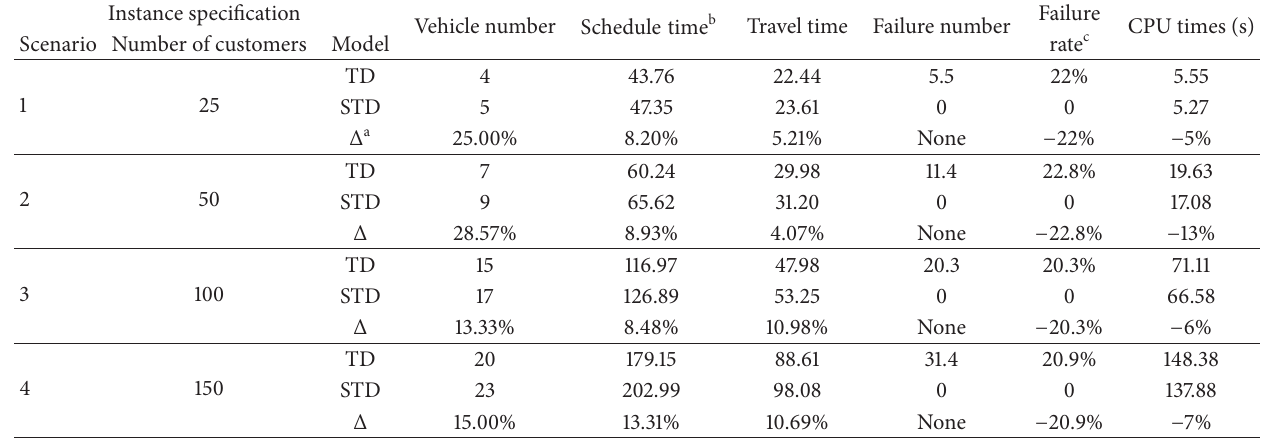
a Δ indicates relative percentage change between the two tests. b